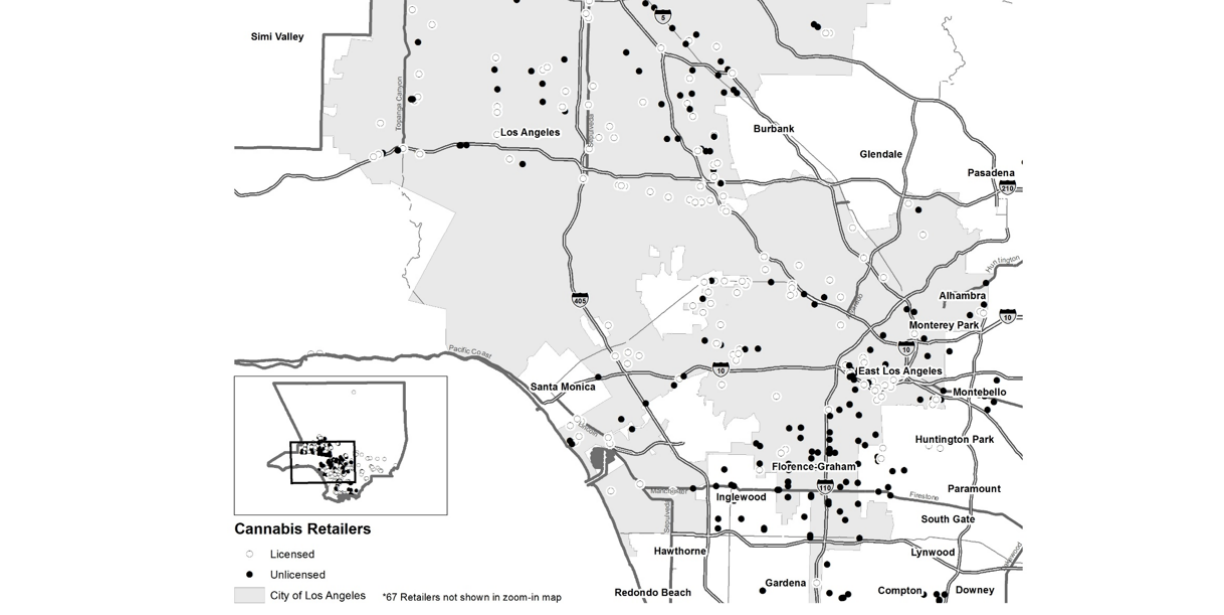
Figure 1. Map of Cannabis outlets in Los Angeles County. (Map is current as of April 2019 when the direct observations were